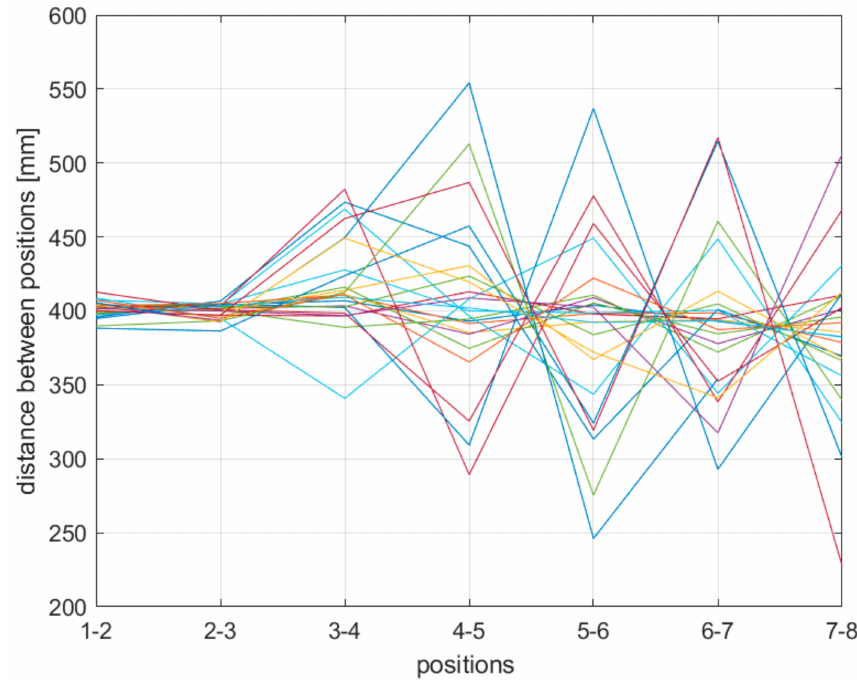
Figure 17. Body joint relative measurements of Azure Kinect in the WFOV mode.